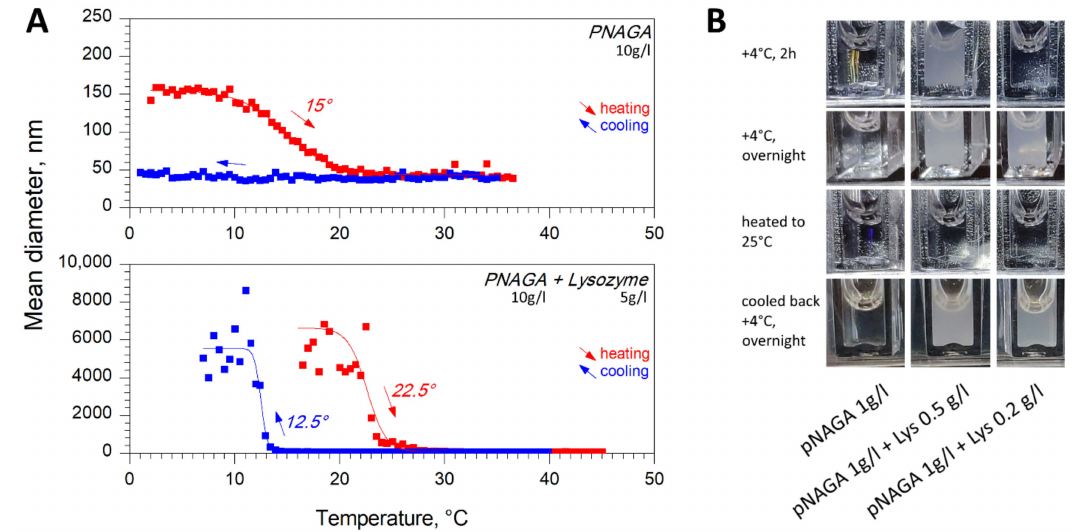
Figure 2. Phase-separation behavior of PNAGA in a solution is altered in the presence of lysozyme. ( A ) Mean diameter of particles determined using DLS for heating (red curves) and cooling (blue curves) of free polymers solutions (top) and their mixtures with lysozyme (bottom). Temperature values of cloud point are presented near the curves. Here, 10 mM phosphate buffer, pH 7.4. ( B ) Cooling down of PNAGA and lysozyme mixtures results in reversible formation of large complexes and decrease in the system transmittance; cooled solutions of free polymers are almost